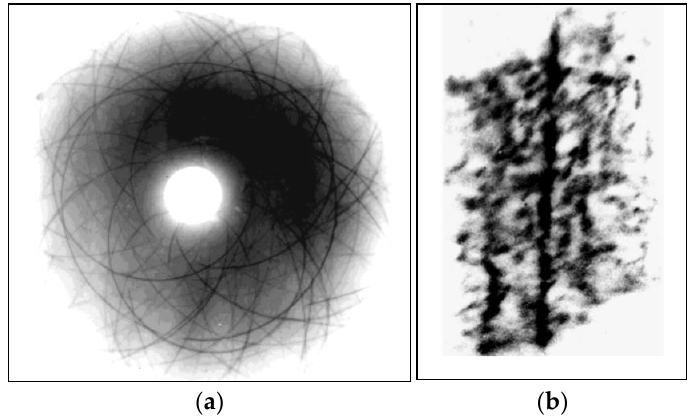
Figure 3. An X-ray diffraction pattern ( a ) and diffraction spots ( b ) of Bi 0.91 Sb 0.09 grown